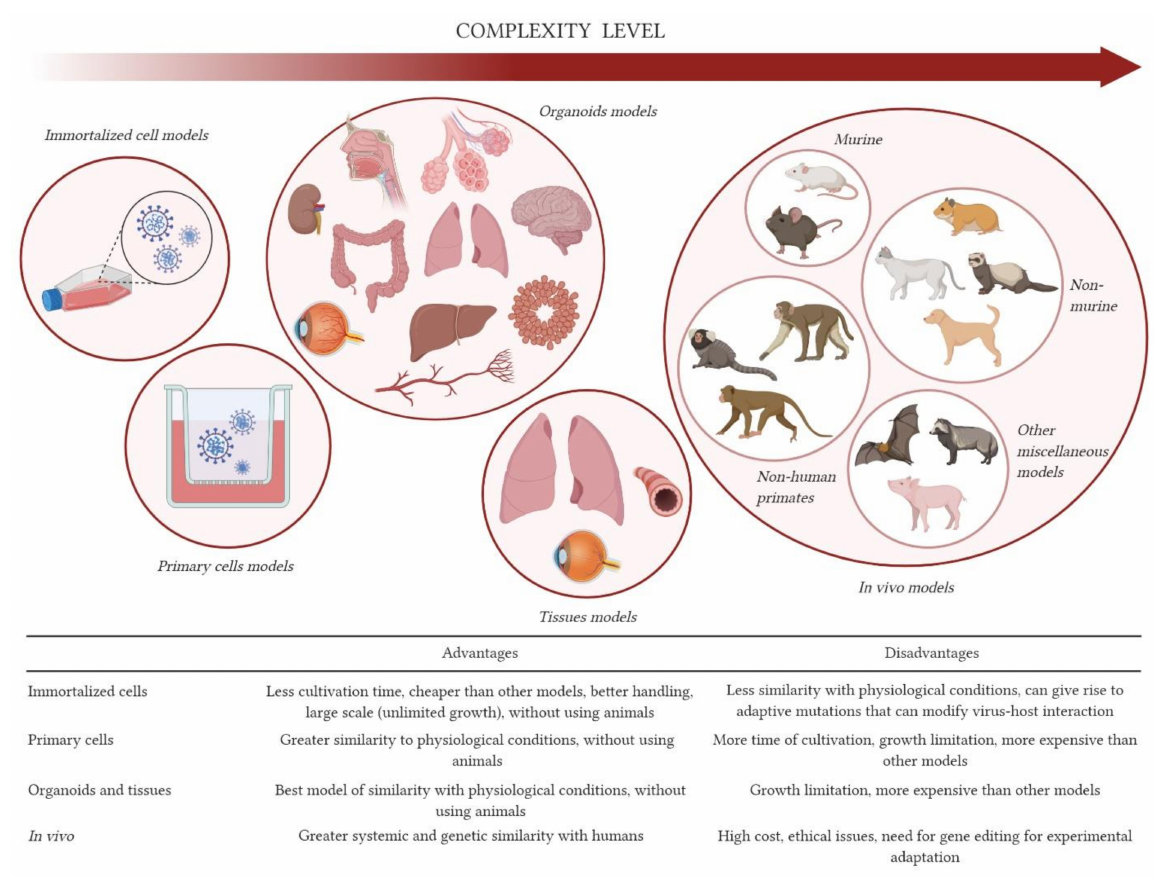
Figure 1. Models for severe acute respiratory syndrome coronavirus 2 (SARS-CoV-2) studies. In vitro, ex vivo and in vivo models previously reported were organized according to complexity level. Advantages and disadvantages of each model are summarized in the table below. Created with